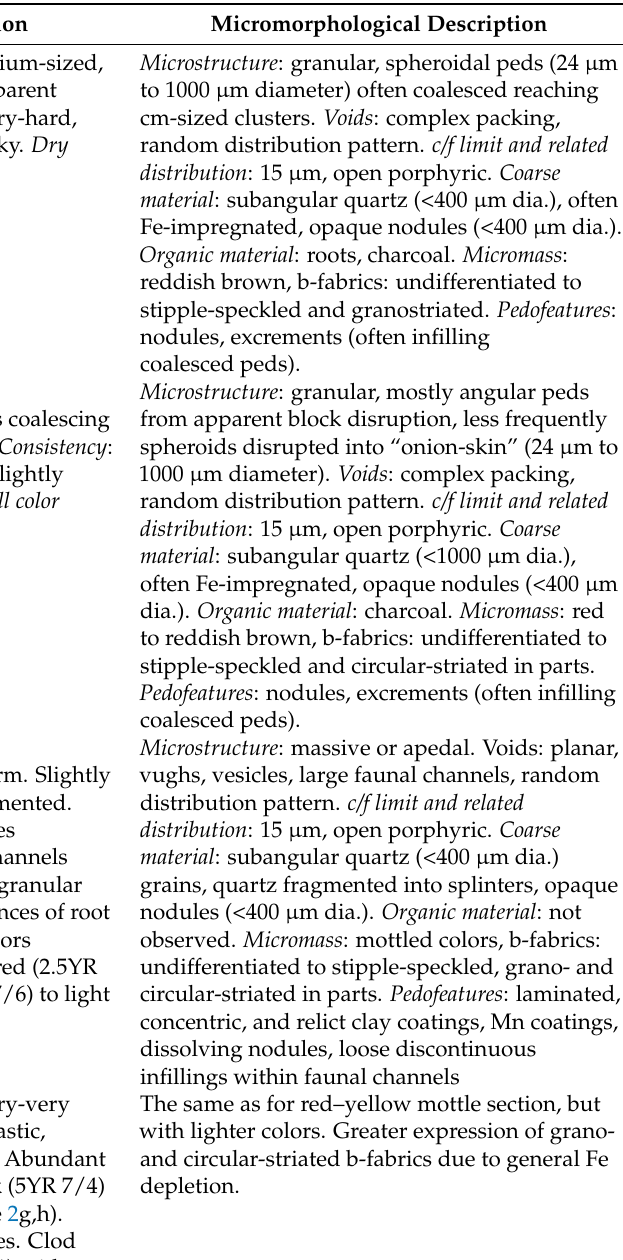
Table 1. Morphological description of the Oxisol and mottled